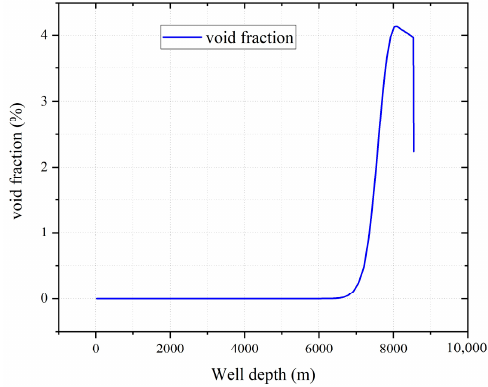
Figure 7. Void fraction diagram in annular space of Well Y.